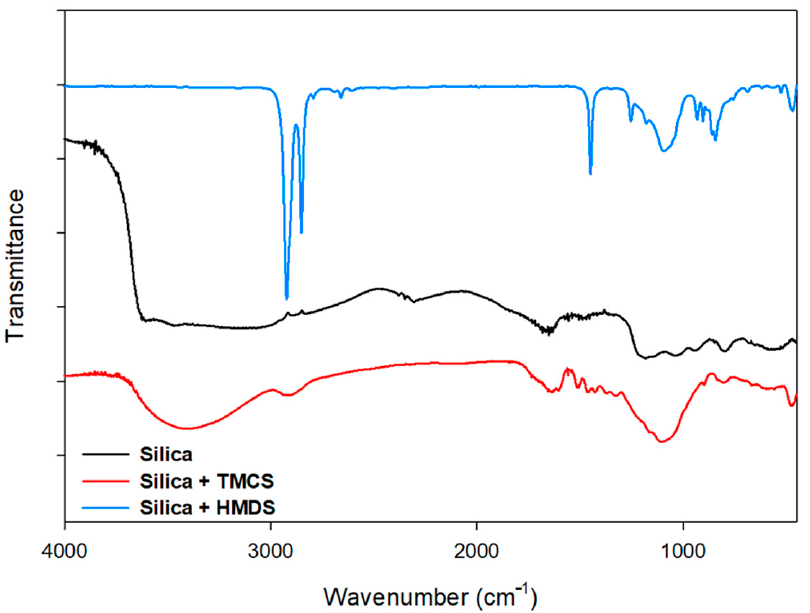
Figure 8. FTIR spectra of silica, superhydrophobic silica dissolved in solvent of n-hexane with TMCS and HMDS.